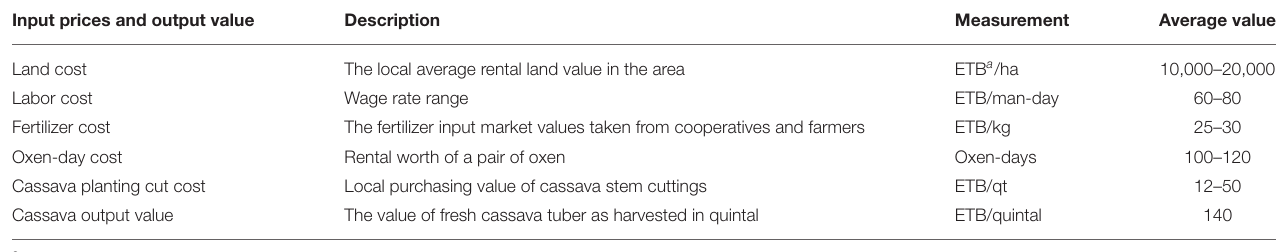
TABLE 4 | Sources of inefficiency variables and their hypothesized